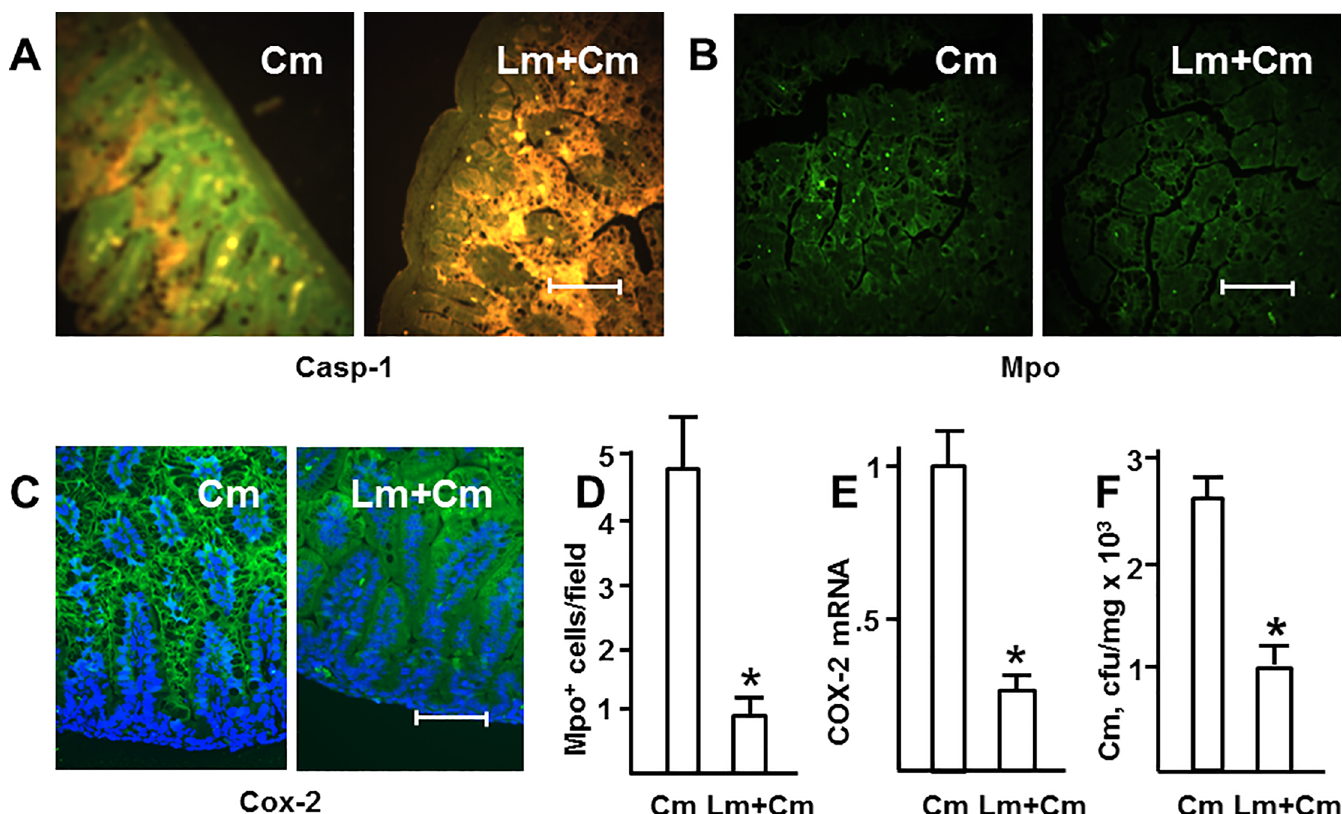
Fig 4. L . murinus reduces molecular markers and intestinal barrier damage of NEC. Localization of active caspase-1 (green, A), myeloperoxidase-positive cells (green, B), and Cox-2 (green, C) in small intestine sections of 4 day old animals inoculated with C . muytjensii (Cm) at 10 6 cfu at the second feeding, without or with pre- inoculation with L . murinus HF12 at 10 8 cfu at the first feeding. Yellow/orange/brown in (A) is non-specific autofluorescence; blue in (C) are DAPI-stained nuclei. Each image is representative of at least 3 animals. Bar = 100 μ m. D, average numbers of Mpo-positive cells in random 200x200 μ m squares (n = 16 in each group). E, relative levels of mucosal COX-2 mRNA (n = 4 in each group). F, loads of C . muytjensii per mg wet weight aseptically excised spleen tissue (n = 10 in each group). Average intestinal loads of C . muytjensii in the two groups were not significantly different (8.2 ± 1.2vs. 7.6 ± 2.0 x 10 5 cfu/ml, p = 0.8). (cid:3) , significant differences (p < 0.01, unpaired t